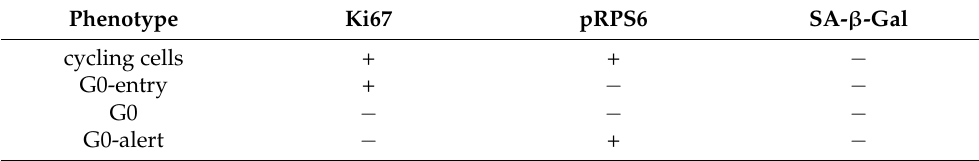
Figure 2. Molecular characterization of cycling and quiescent cells. Panel ( A ): Representative micrographs of MSCs stained to identify nuclei (DAPI), pRPS6, and Ki67 and to evaluate SA- β -gal activity. See also Supplementary File S1. The scale bar corresponds to 100 microns. Panels ( B – E ): Graphs show the percentage of cycling, G0-entry, quiescent and G0-alert cells at different time points (AP, S1, S2, S3, Q, T1, T2, T3, P). Below each graph, the molecular algorithm we used to identify the different phenotypes is indicated. In each graph, the * indicates the statistical difference between AP, chosen as the reference, and S1, S2, S3, and Q (* p < 0.05, ** p < 0.01, *** p < 0.001). The # indicates the statistical difference between Q, chosen as the reference, and T1, T2, T3, and P (# p < 0.05, ## p < 0.01, ### p < 0.001). Table 1. Molecular algorithm to identify cell